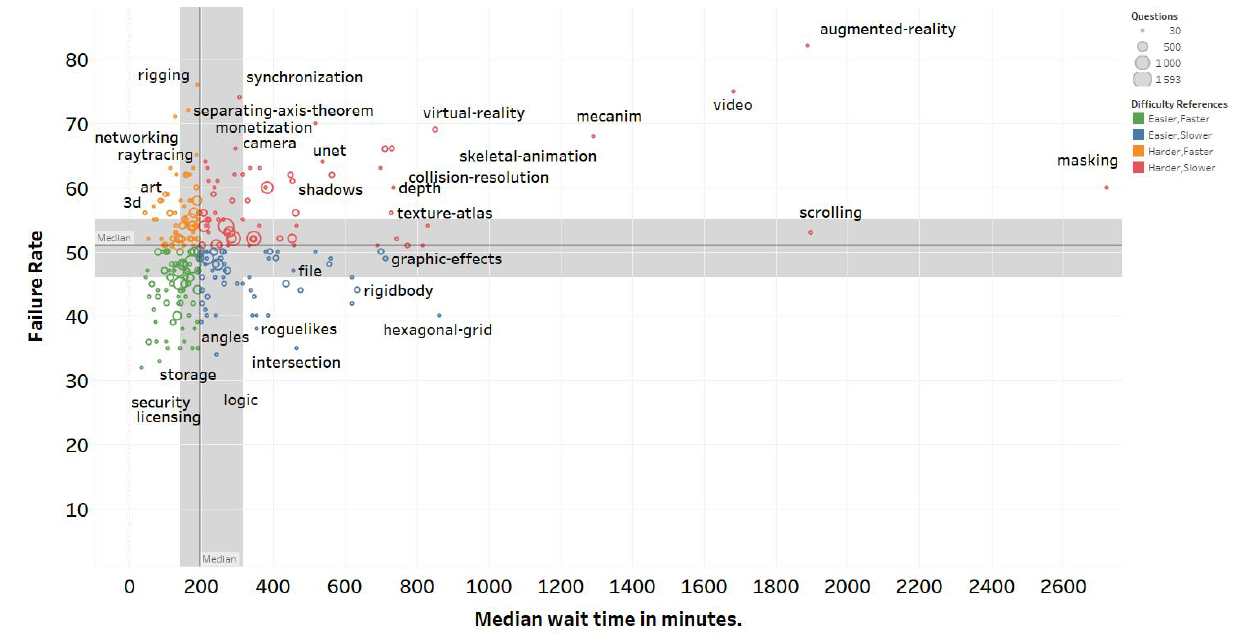
Figure 6. Community support for concept Tags. Reference point is based on median values (51% for the Failure Rate, 195 minutes for the Wait Time). Circle sizes indicate the number of questions of the